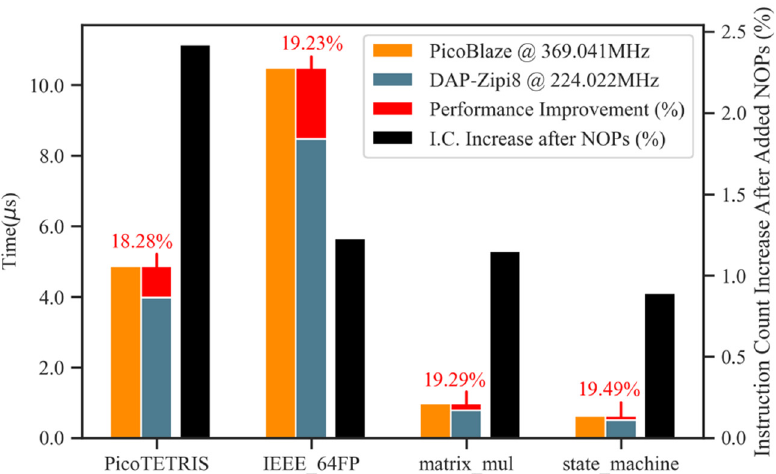
Figure 14. PicoBlaze vs. Zipi8 vs. DAP-Zipi8 performance and resource utilization comparison.